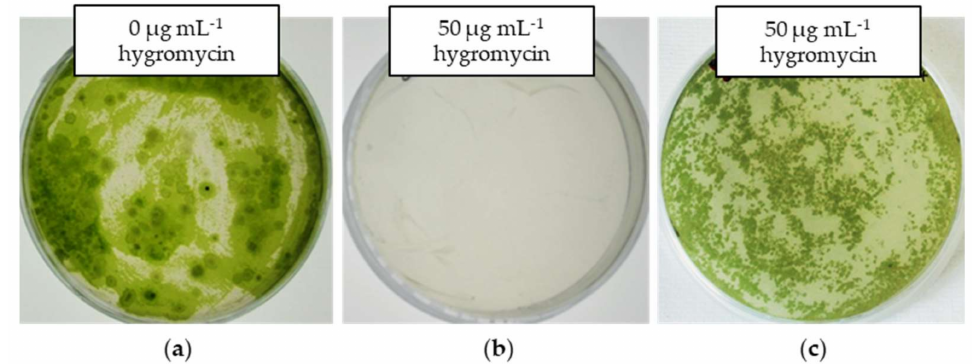
Figure 3. Agrobacterium -mediated transformed E. gracilis cells. ( a ) Wildtype E. gracilis cells on a hygromycin-free organic medium. ( b ) E. gracilis cells cocultivated with Agrobacterium cells harboring a plasmid without the resistance/reporter gene cassette and plated on an organic medium containing 50 µ g mL − 1 hygromycin. No colonies of E. gracilis were observed. ( c ) E. gracilis cells transformed with Agrobacterium harboring a plasmid with the resistance/reporter marker gene cassette and plated on an organic medium containing 50 µ g mL − 1 hygromycin. Hygromycin-resistant colonies of E. gracilis were observed on selective plates.